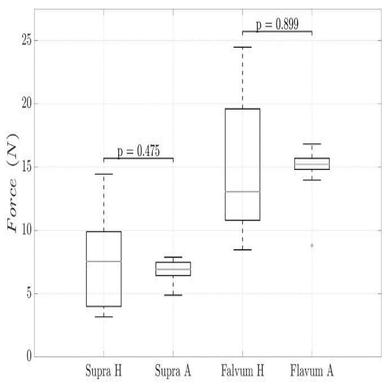
Results of the peaks of the needle insertion force for the lig. supraspinale (Supra) and flavum (Flavum) compared between human specimens (H; n ¼ 11) and artificial phantom (A; n ¼ 11).